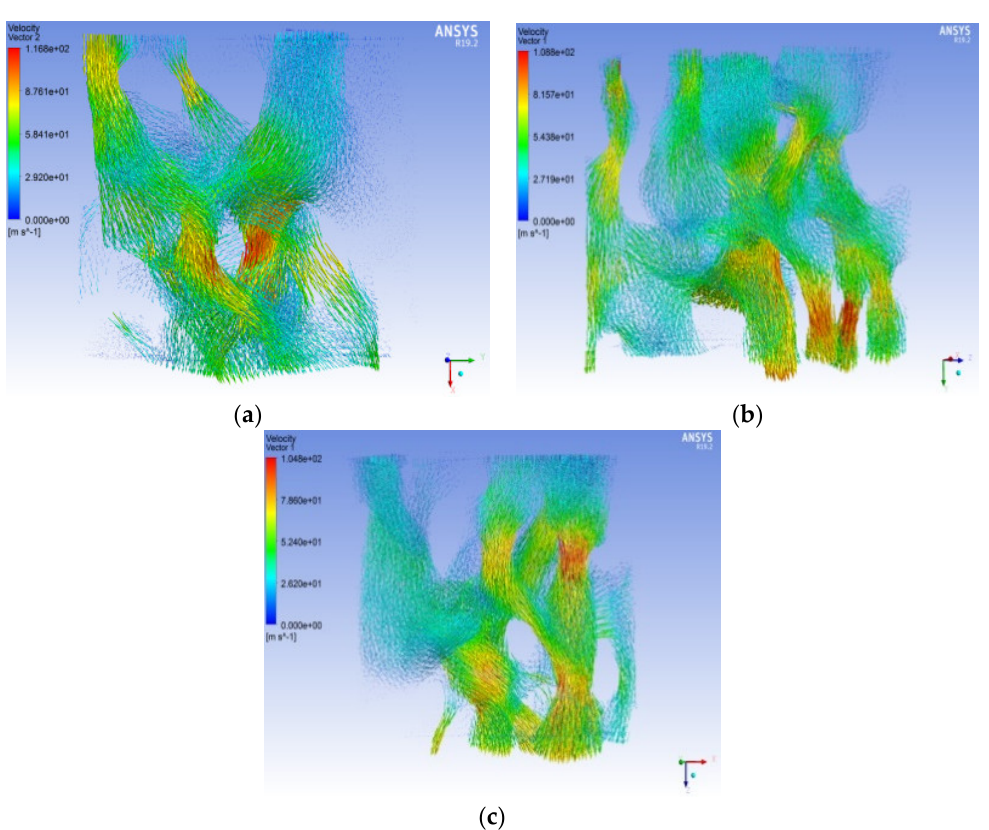
Figure 21. X, Y, and Z negative single channel seepage velocity distribution vector diagram. ( a ) X negative direction, ( b ) Y negative direction, and ( c ) Z negative direction.